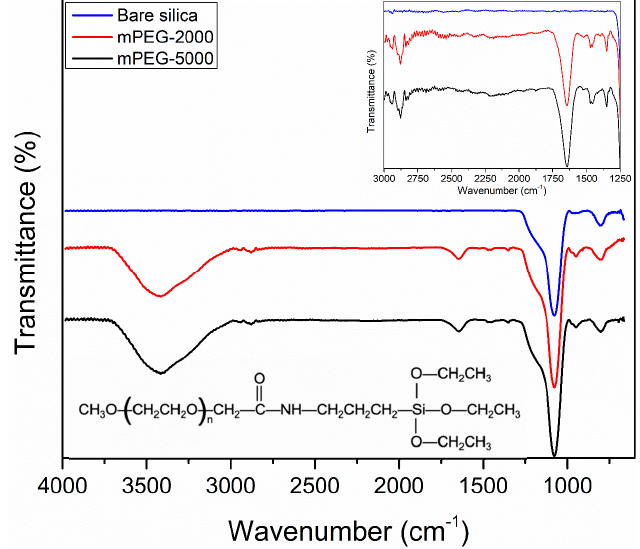
Figure1. Fouriertransforminfrared(FTIR)spectraofbaresilicaandpolyethyleneglycol(mPEG)-grafted silica particles. Insets show the zoomed in spectra and the chemical structure of